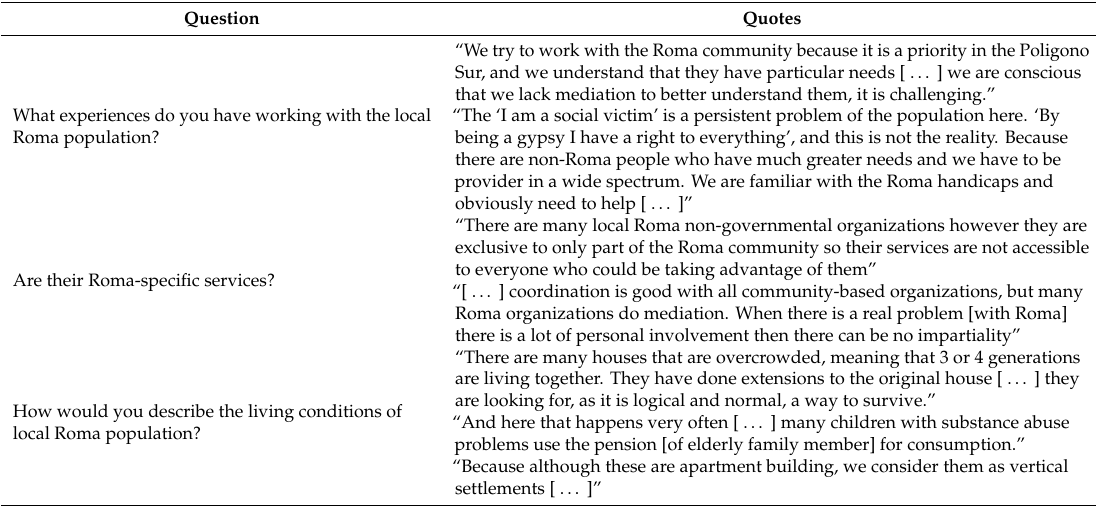
Table 1. Sample quotes from stakeholder interviews for Poligono Sur (PS) rapid assessment.